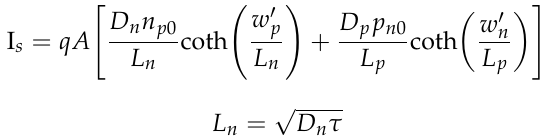
Figure 5. The schematic layout of the designed 9T GS pixel.